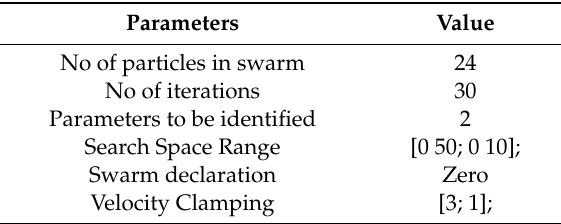
Table 2. Tested PSO parameters.